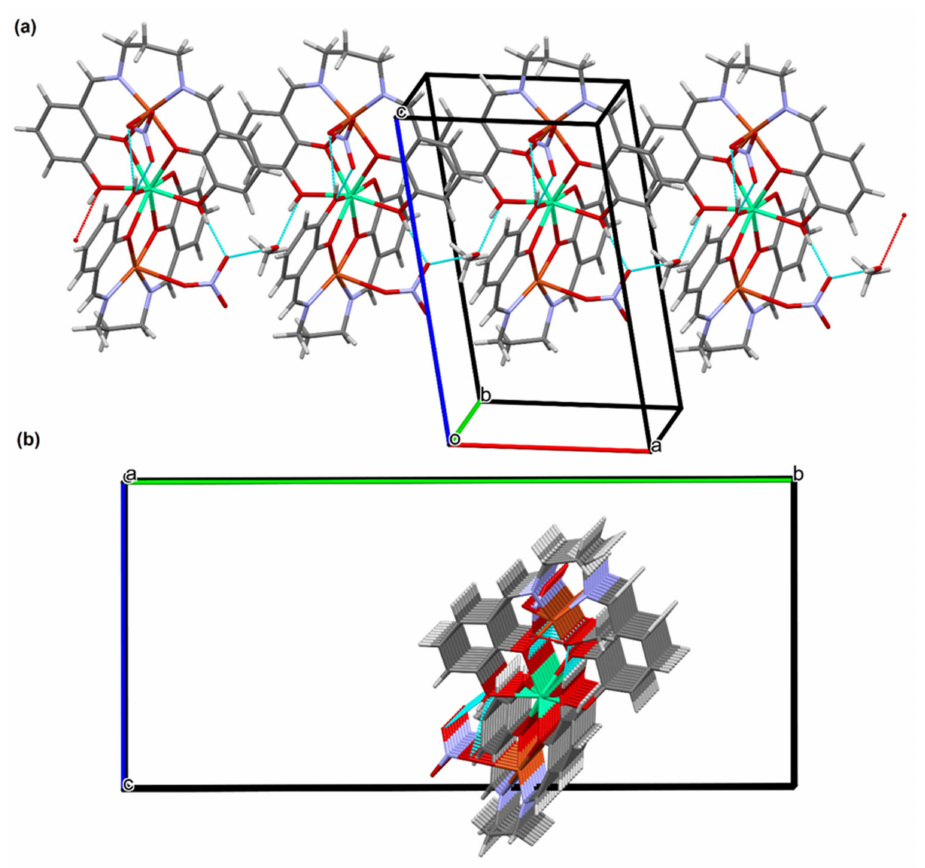
Figure 6. ( a ) A partial viewed along the b -axis direction of the crystal packing of 1 with hydrogen bonds shown as dashed lines; ( b ) A partial viewed along the a -axis direction of the crystal packing of 1 with hydrogen bonds shown as dashed